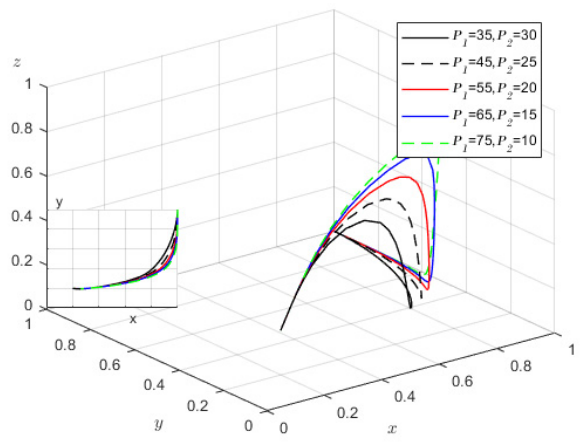
Figure 7. The impact of government rewards and punishments.